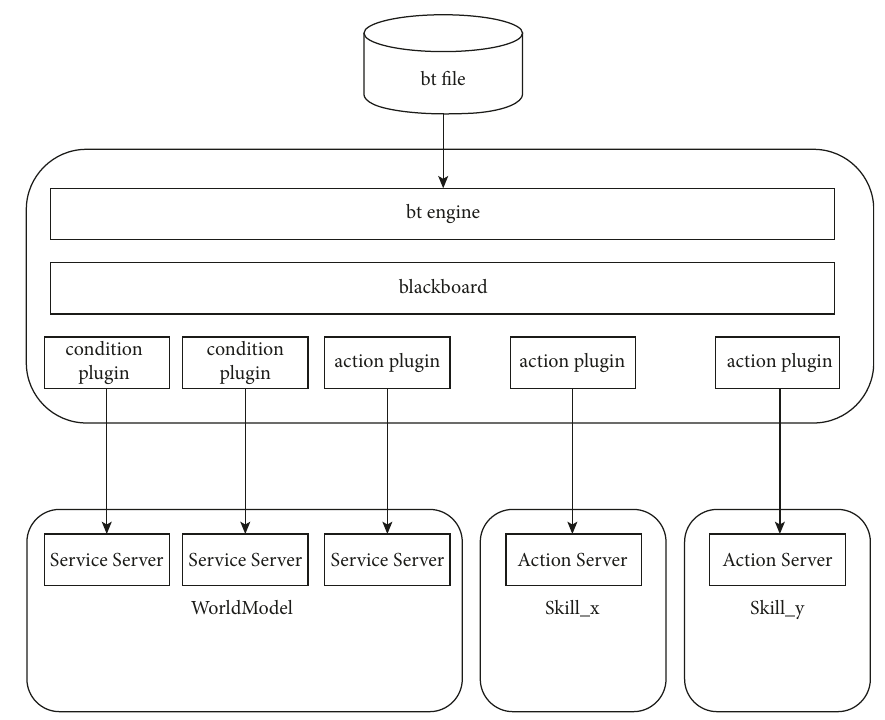
Figure 13: Behavior tree execution